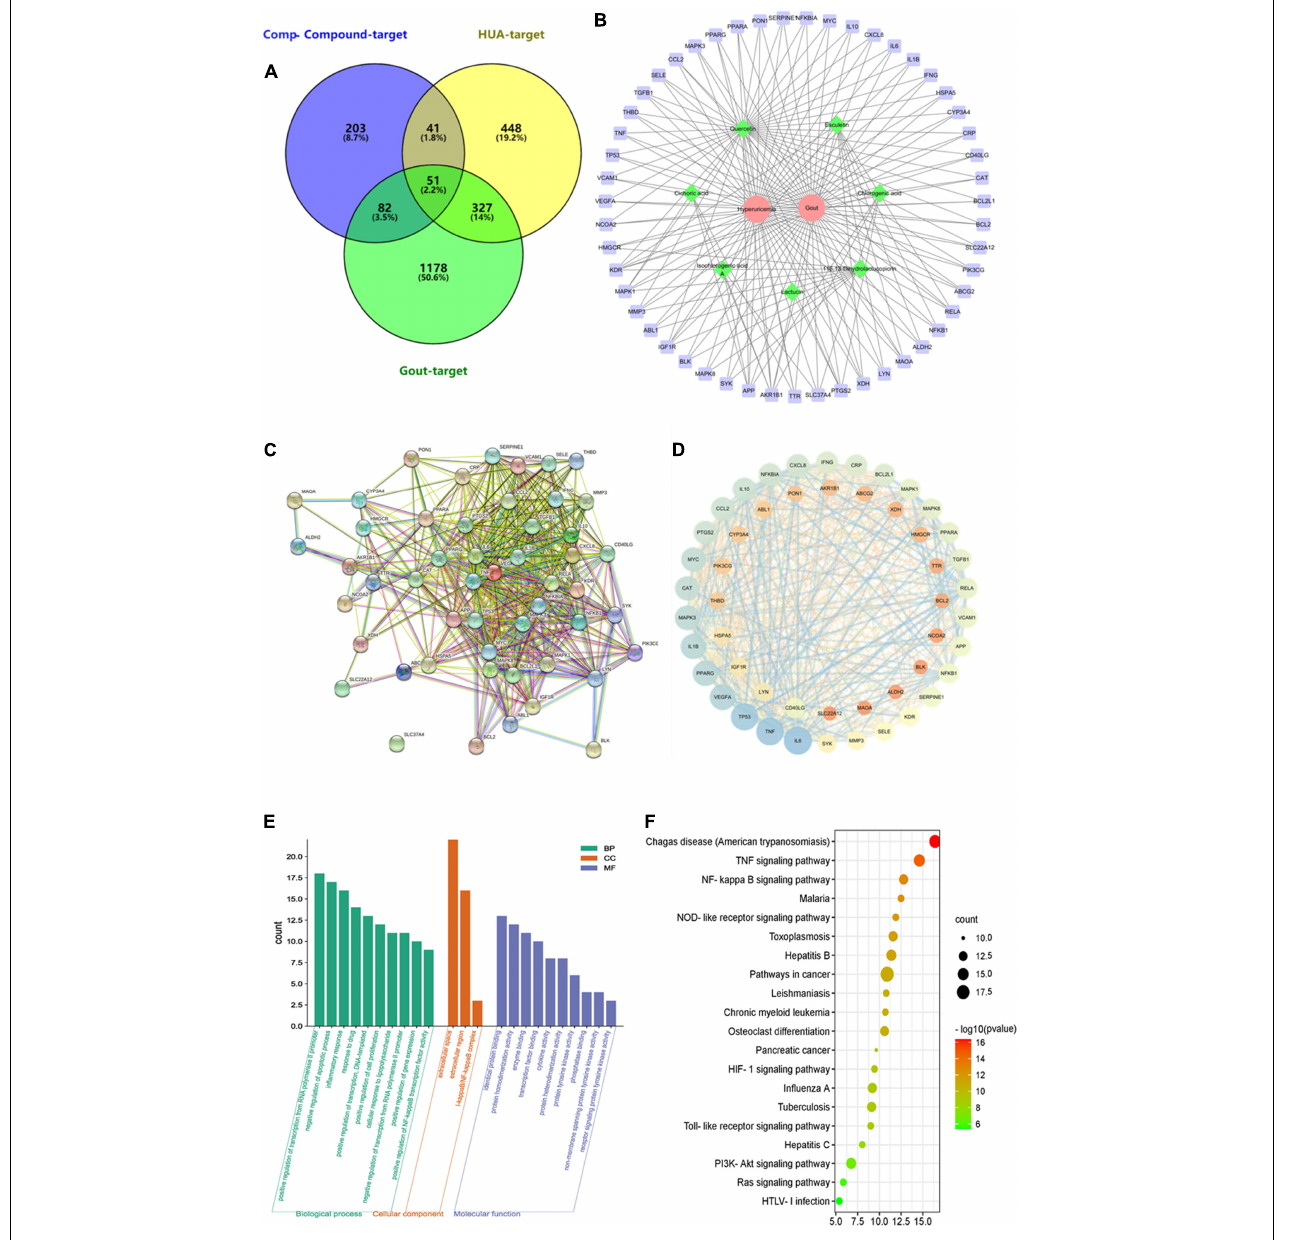
FIGURE 9 | The target network of chicory. (A) The Venn diagram between constituent-related targets and gout-HUA-related targets; (B) Component-target-disease network. Red represents the disease, green represents the component, and purple represents the target; (C) The PPI network; (D) The PPI visual network diagram; (E) Component-disease target GO functional enrichment histogram; and (F) KEGG